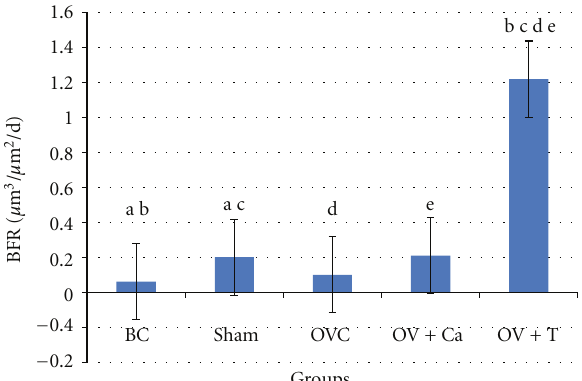
Figure 5: Bone formation rate (BFR/BS). BC: baseline control group. Sham: sham-operated rats given deionised water and vehicle olive oil. OVC: ovariectomised rats given deionised water and vehicle olive oil. Ov+Ca: ovariectomised rats given 1% calcium in deionised water and vehicle olive oil. Ov+T: ovariectomised rats given deionised water and palm tocotrienol. Same alphabet indicates significant di ff erence between the groups ( P < 0 .